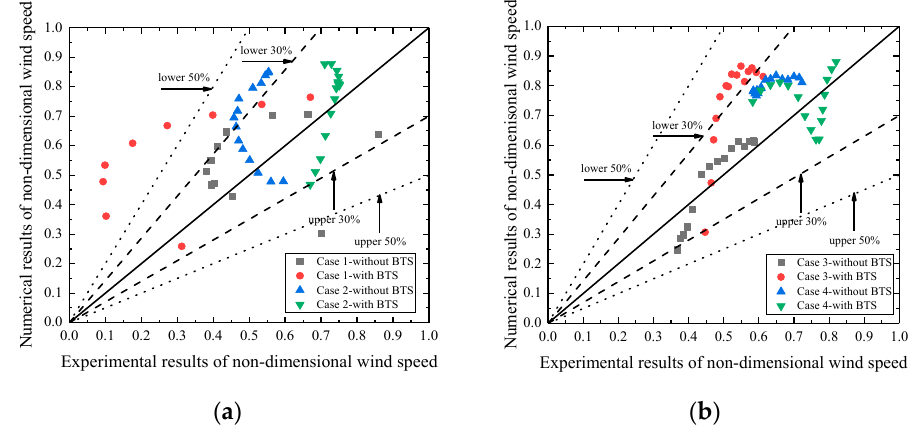
Figure 14. Numerical results vs. experimental results of non-dimensional cross-bridge wind speed at main deck level under different cases. ( a ) Case 1 and 2; ( b ) Case 3 and 4.